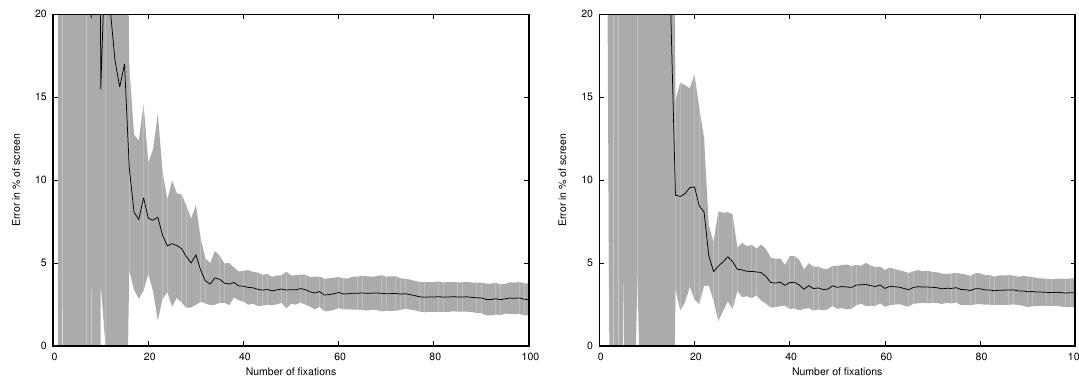
Figure 10. Error for the headset eye tracker and MCF DIR incremental algorithm depending on the number of fixations. Left: horizontal error, right: vertical error. Gray area represents standard